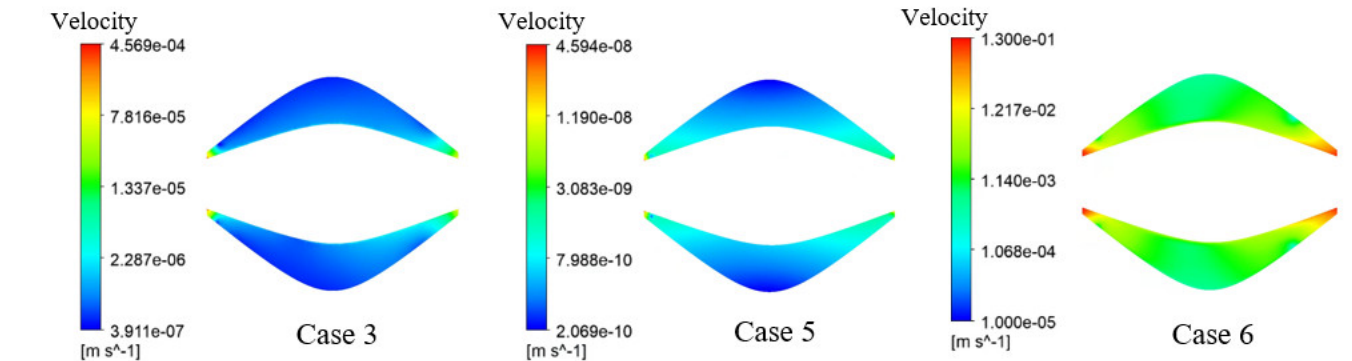
Figure 4. Contours showing the distribution of ILT filtration velocities (i.e., flow through the porous ILT tissue) for cases with varying ILT permeability on the logarithmic scale (Case 3 with K avg , Case 5 with K min , and Case 6 with K max ) . Contour colors show the magnitude of the interstitial flow. In the insets, the velocity contour is shown for the ILTs only, and each case with its own scale.